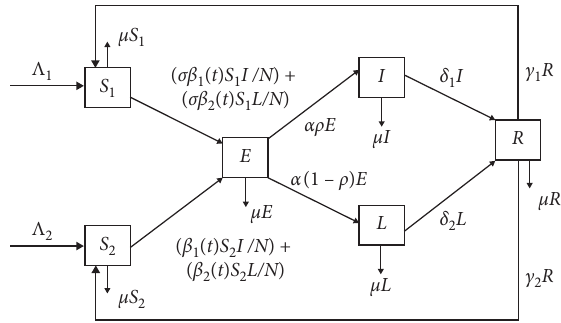
Figure 2: Flowchart of compartments of the HFMD